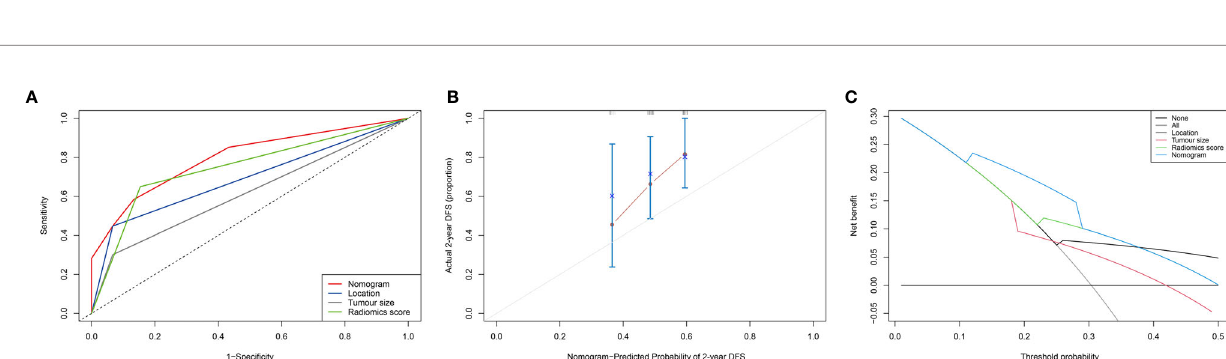
FIGURE 3 | The clinical-radiomics nomogram: The radiomics score-based nomogram for the prediction of DFS was developed in the cohort, and the radiomics score, tumour location and tumour size